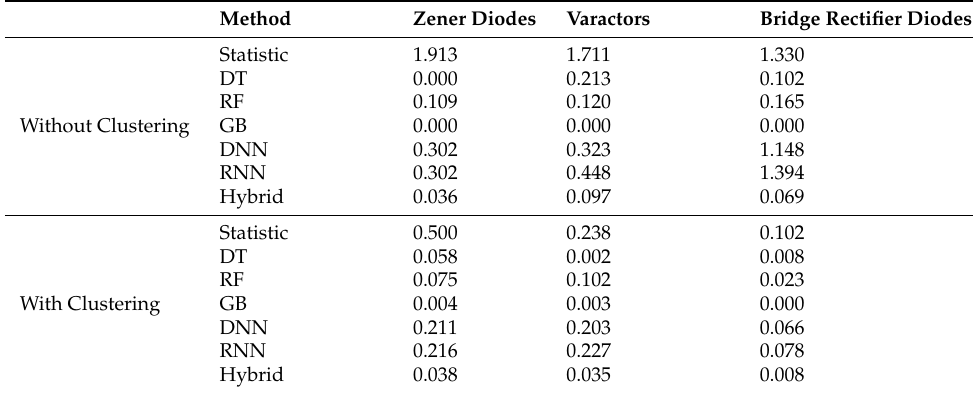
Table 10. RMSRE of the training data with and without